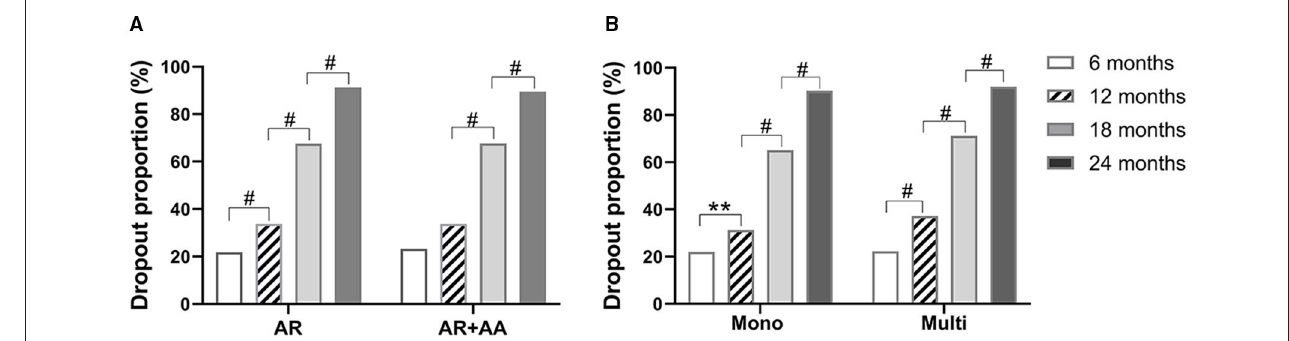
FIGURE 2 | Dropout rates of SLIT in AR patients with or without AA (A) , and patients with different sensitization statuses (B) at different times. AR, allergic rhinitis; AA, allergic asthma. Mono, sensitized only to HDM; multi, sensitized to other aeroallergens in addition to HDM. ** P < 0.01; # P < 0.001.